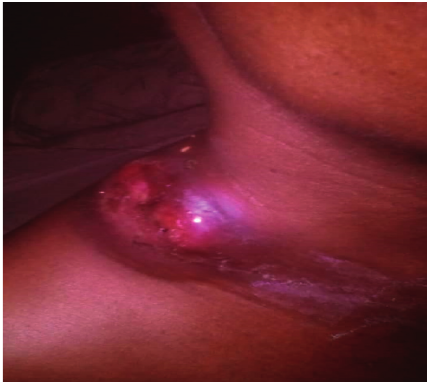
Figure 1: Photograph of neck mass at the first presentation. Figure